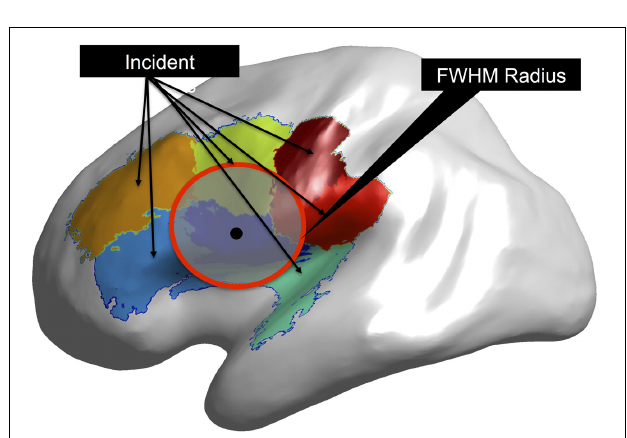
FIGURE 3 | Calculation of Full Width Half Max (FWHM). For each dipole used in the simulation (black dot) the FWHM is calculated (red circle) as list of points on the cortical surface within that radius. Clusters that are incident within the FWHM radius are part of the FWHM true positive